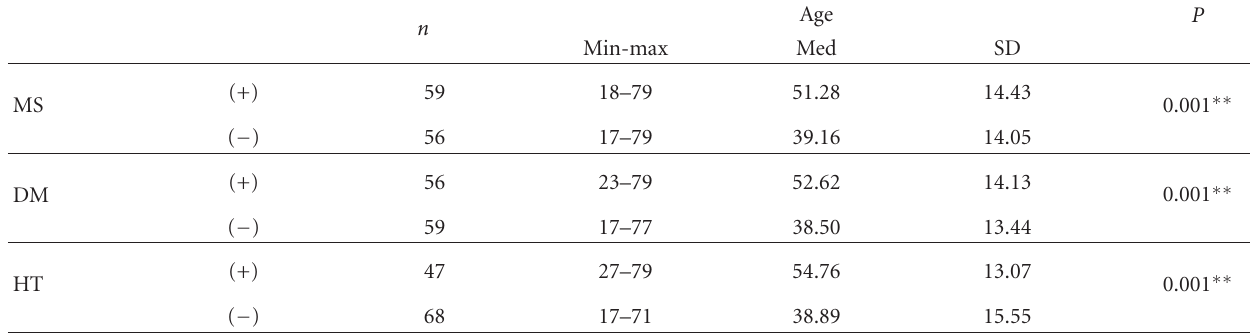
Table 2: Association of MS, DM, and HT with age in psoriasis